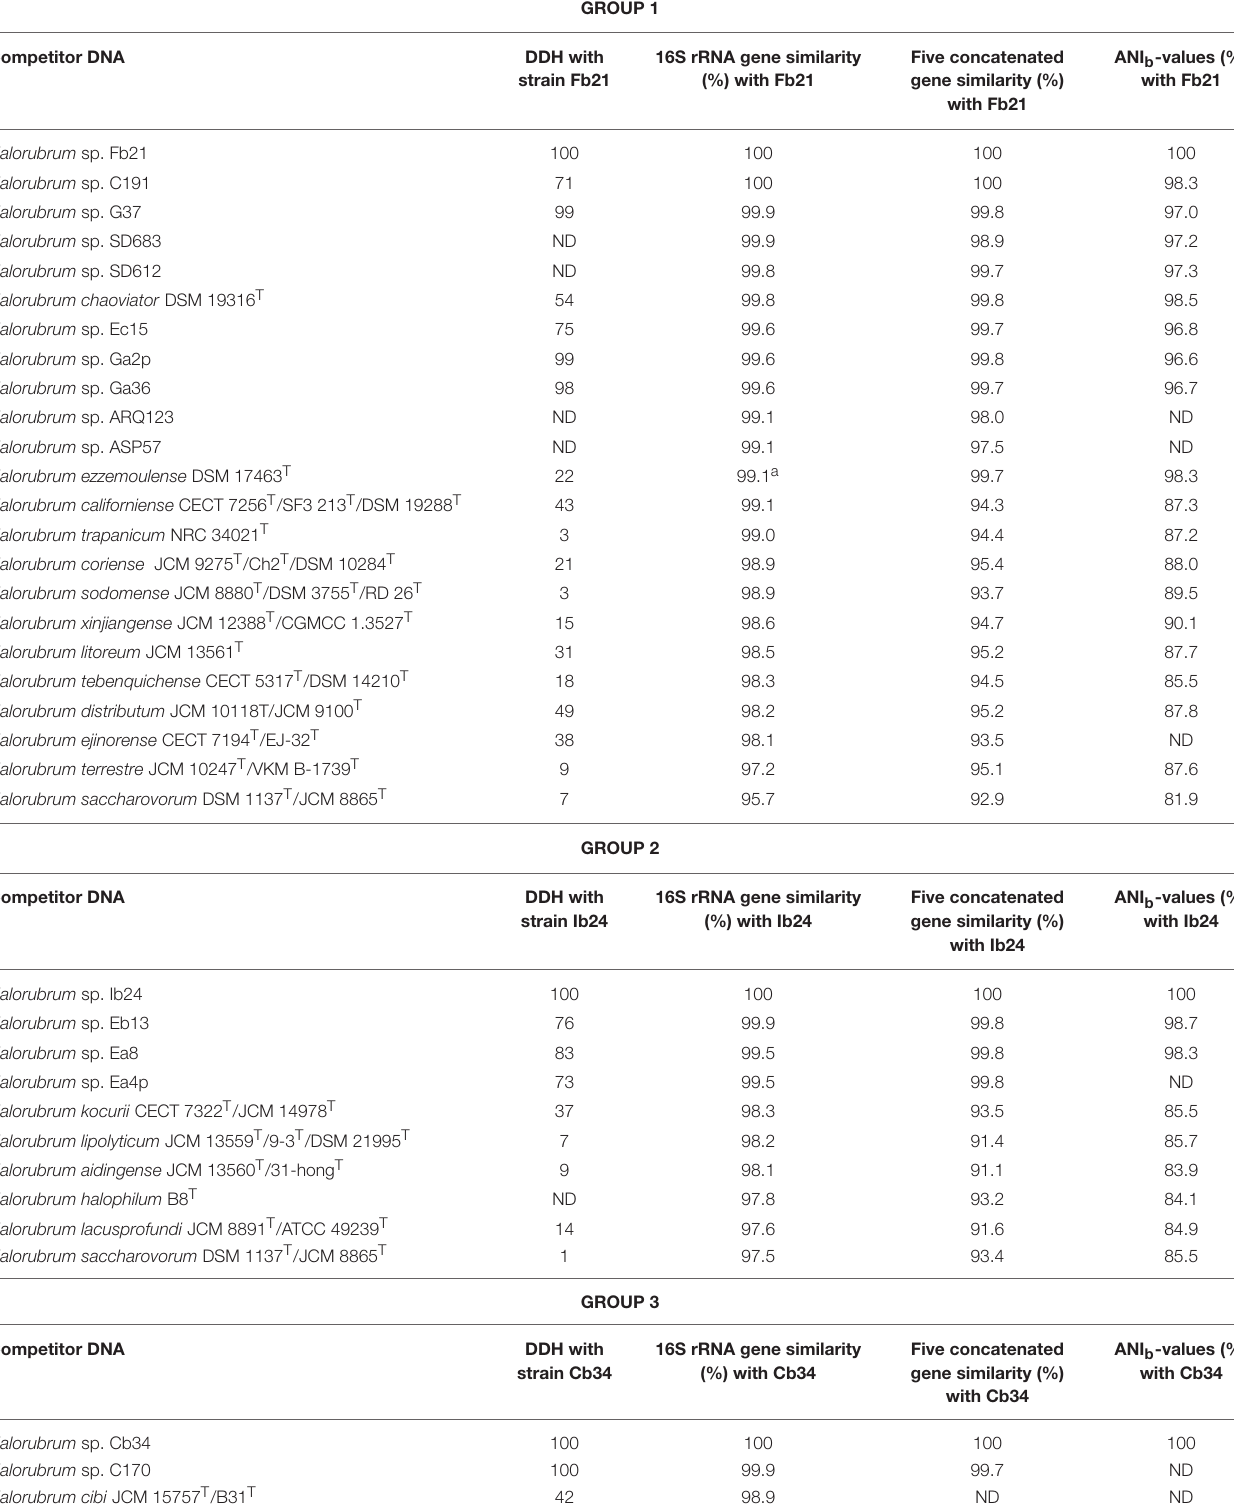
TABLE 3 | DNA–DNA hybridization data (%) among representative strains of groups 1 (Fb21), 2 (Ib24), and 3 (Cb34) and its closest relatives.